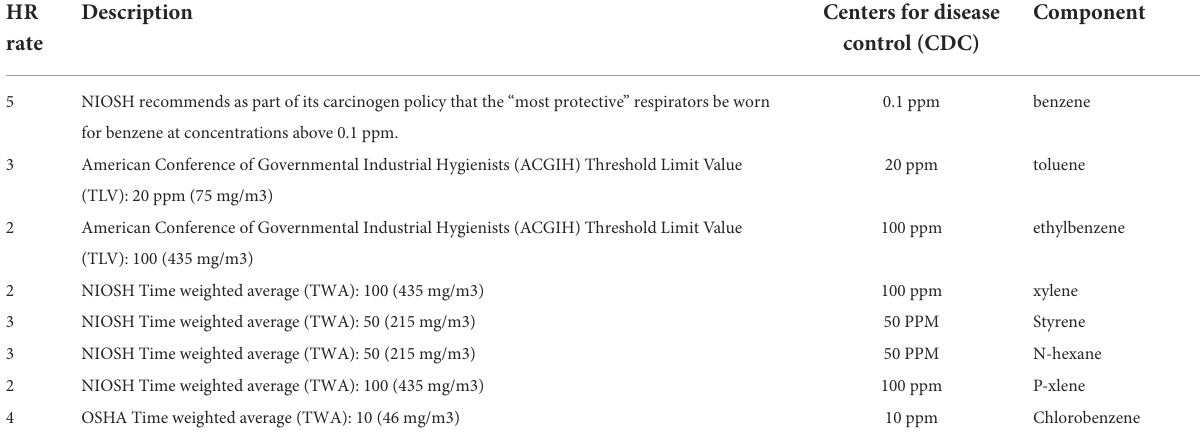
TABLE 1 The calculation of the hazard rate for VOCs investigated in this research (19). HR Description rate